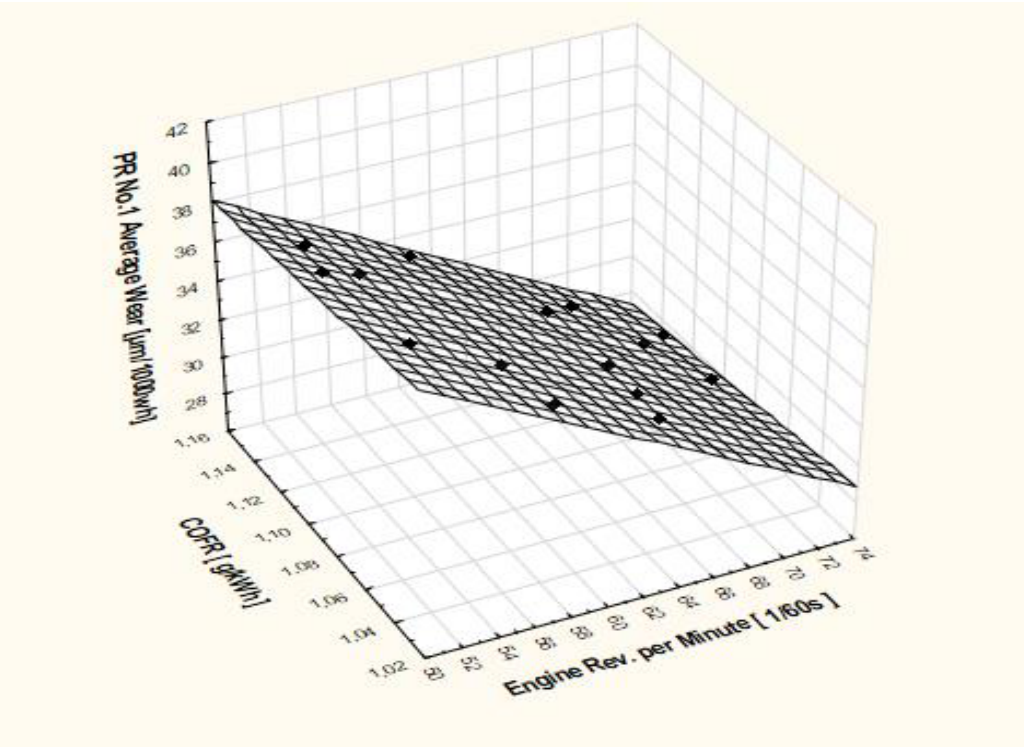
Figure 3. Results of average wear rates for PR No. 1 in all engine units, depending on COFR and the engine’s RPM (piston speed).